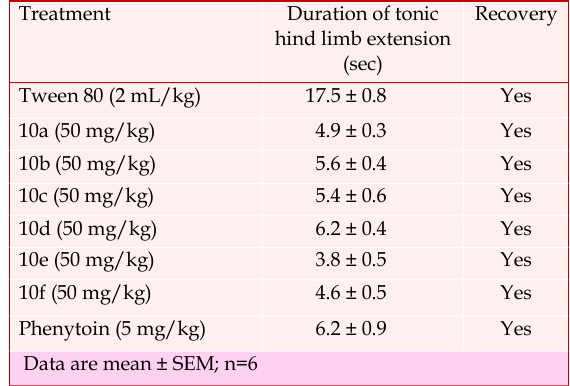
Anticonvulsant activity of novel Schiff bases Treatment